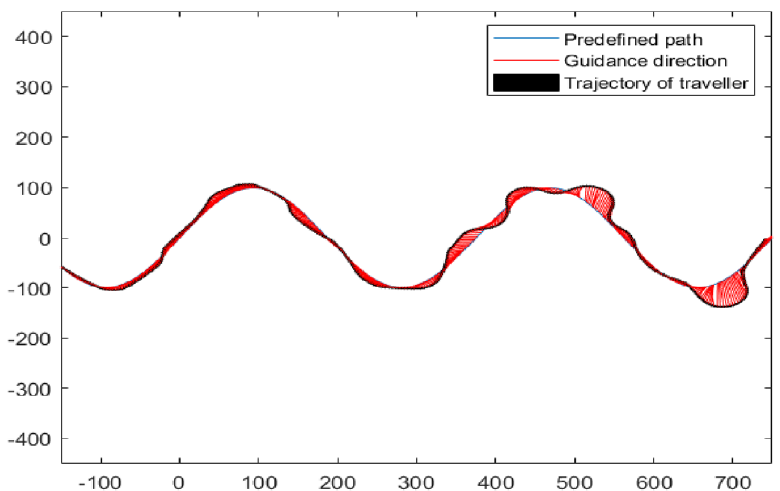
Figure 11. Predefined path, guiding force, and trajectory of traveler in virtual fields tests.